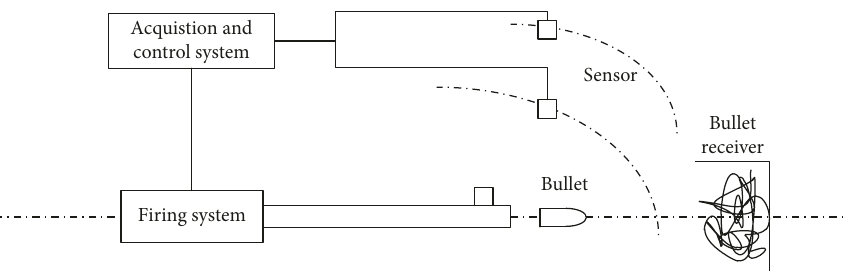
Figure 3: Schematic diagram of the test scheme.